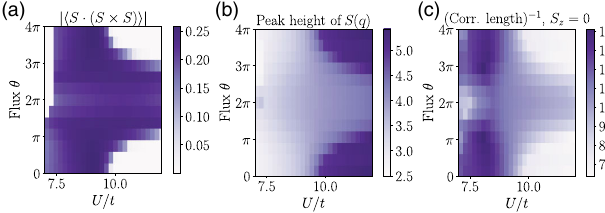
FIG. 8. YC6 cylinder with flux insertion θ , for χ ¼ 8000 . (a) Absolute value of the chiral order parameter. (b) Maximum of h S z S z i structure factor on allowed momentum cuts in the Brillouin zone. (c) Inverse correlation length for excitations with S